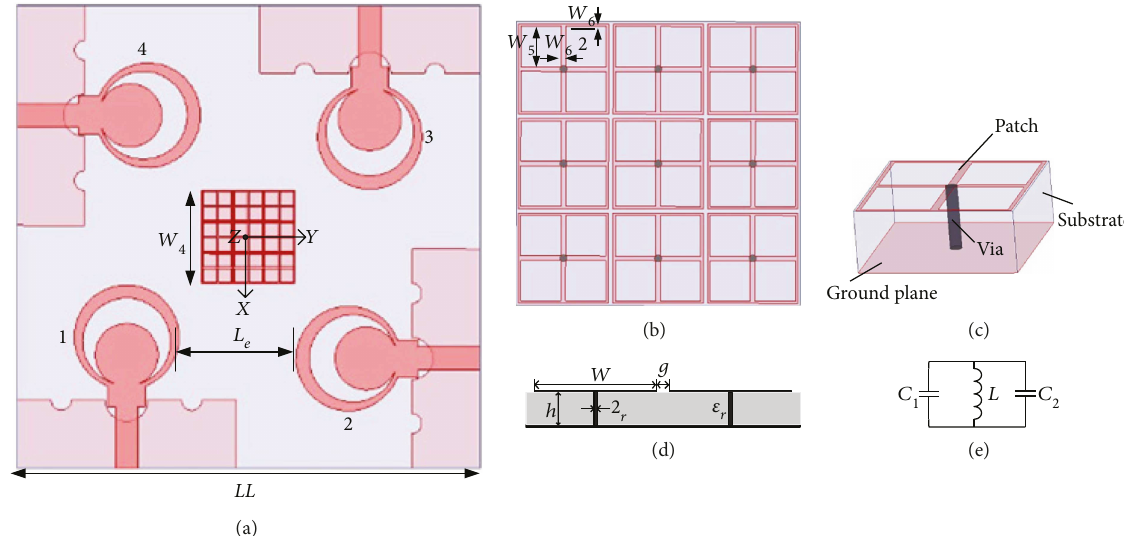
Figure 3: (a) Geometry and parameters of a four-port UWB-MIMO antenna. (b) A 3 × 3 EBG array structure. (c) Geometry of a unit cell. (d) Parameters of a unit cell. (e) The equivalent parallel LC resonant circuit. Dimensions (unit: mm): W =1.75, W =0.2, W =3.9, g =0.1, h =1.6, and r =0.15. W 5 6